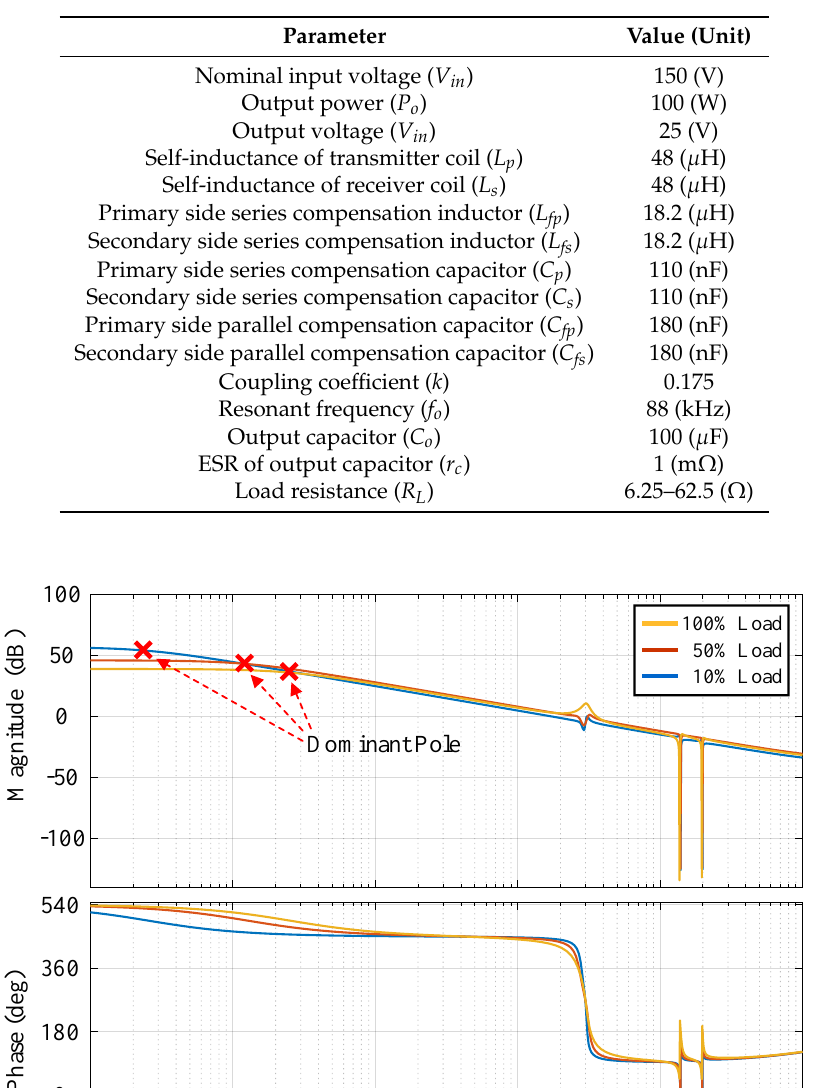
Table 1. System specifications and circuit parameters.